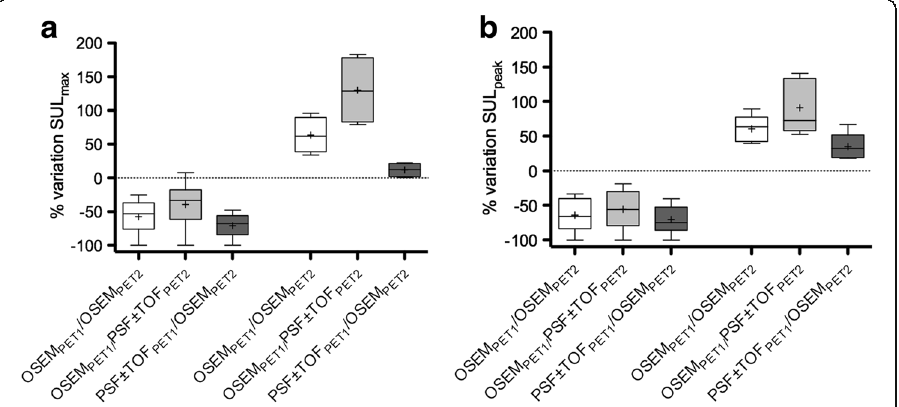
Fig. 2 Impact of reconstruction consistency on the percentage variation in lesions SUL max ( a ) and SUL peak ( b ) in responding ( left panel ) and progressing ( right panel ) tumours. Data are shown as Tukey box plots. Lines denote median values as well as 10th and 90th percentiles. Crosses represent the mean